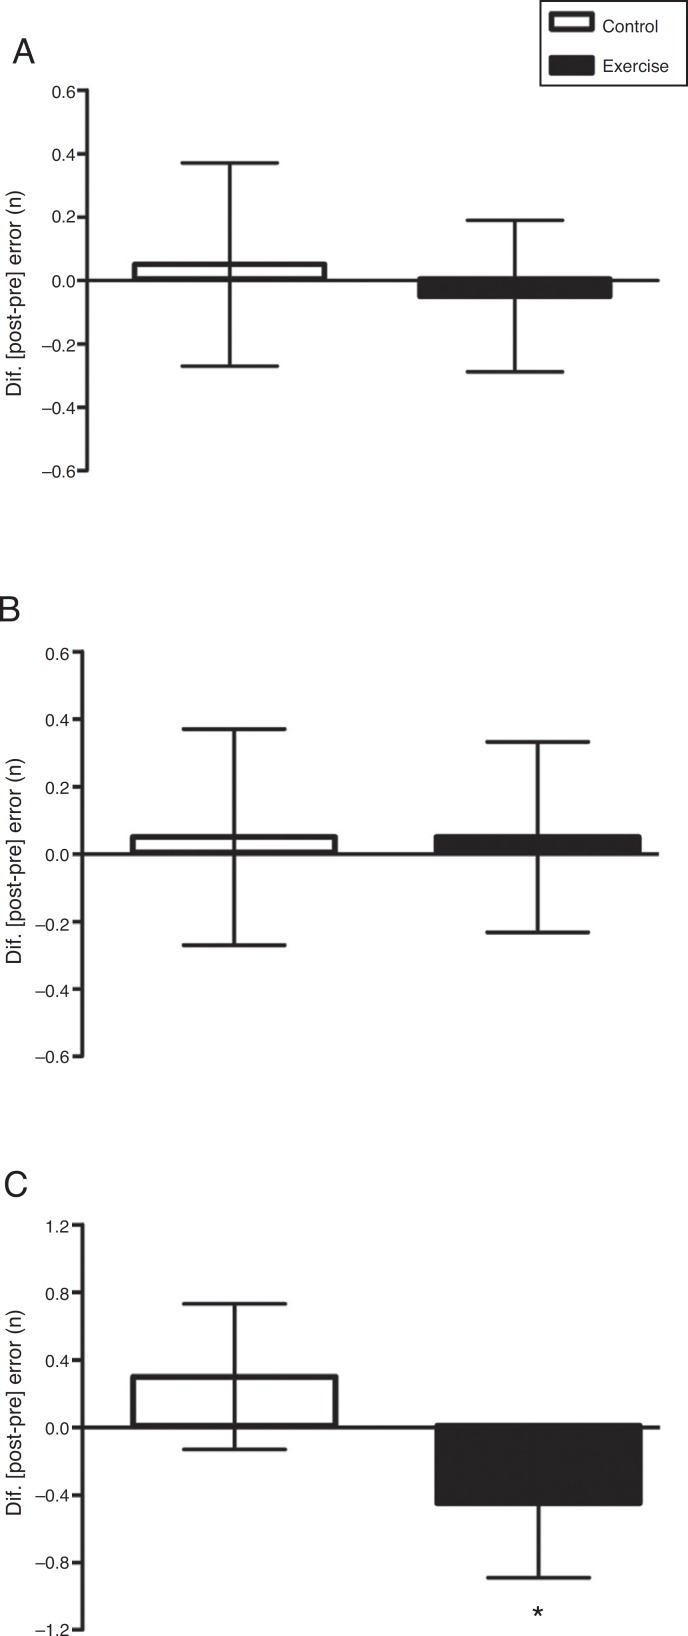
Acute effect of vigorous aerobic exercise on the errors made in Phases 1 (A), 2 (B) and 3 (C) of the computerized Stroop Test (Testinpacs®). Non-parametric Ancova adjusted for chronological age was applied in the comparison between conditions. The delta data (Δ = post-pre) are shown as mean and 95% confidence interval (95%CI). *p<0.011; control × exercise.